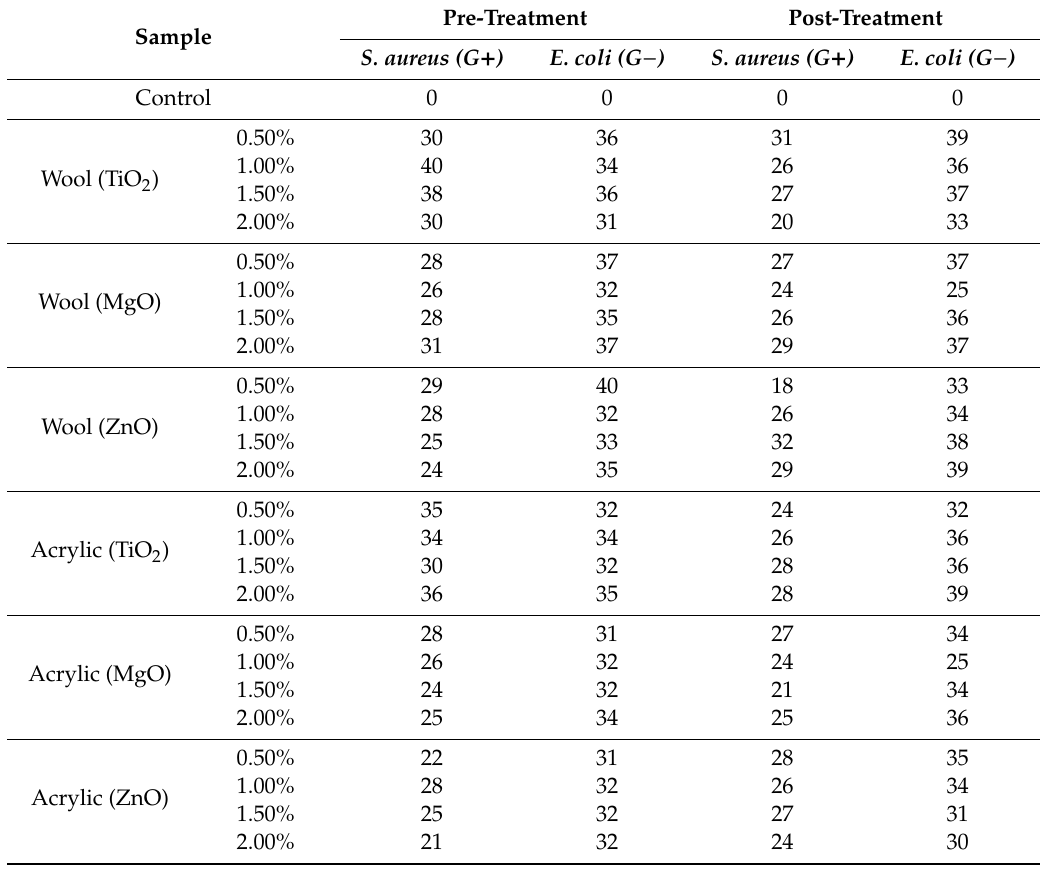
Table 7. Antibacterial activity for the printed wool (TGPLA and acid dyestu ff ) and acrylic (CLMA and basic dyestu ff ) fabrics pre- and post-treated with metal oxide